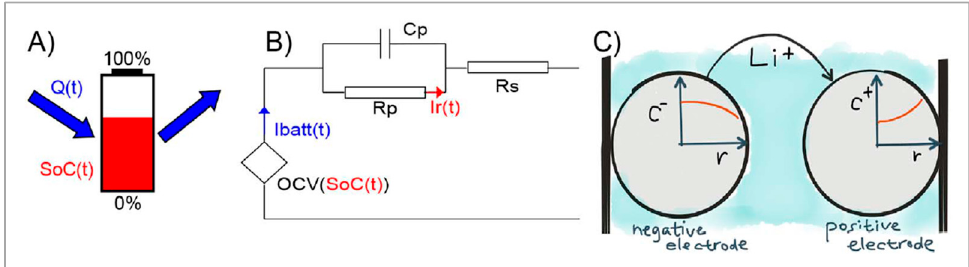
Figure 3 . Representation of the numerical models. ( A ) Bucket Model, ( B ) Equivalent Circuit Model and ( C ) Electrochemical Model [49].